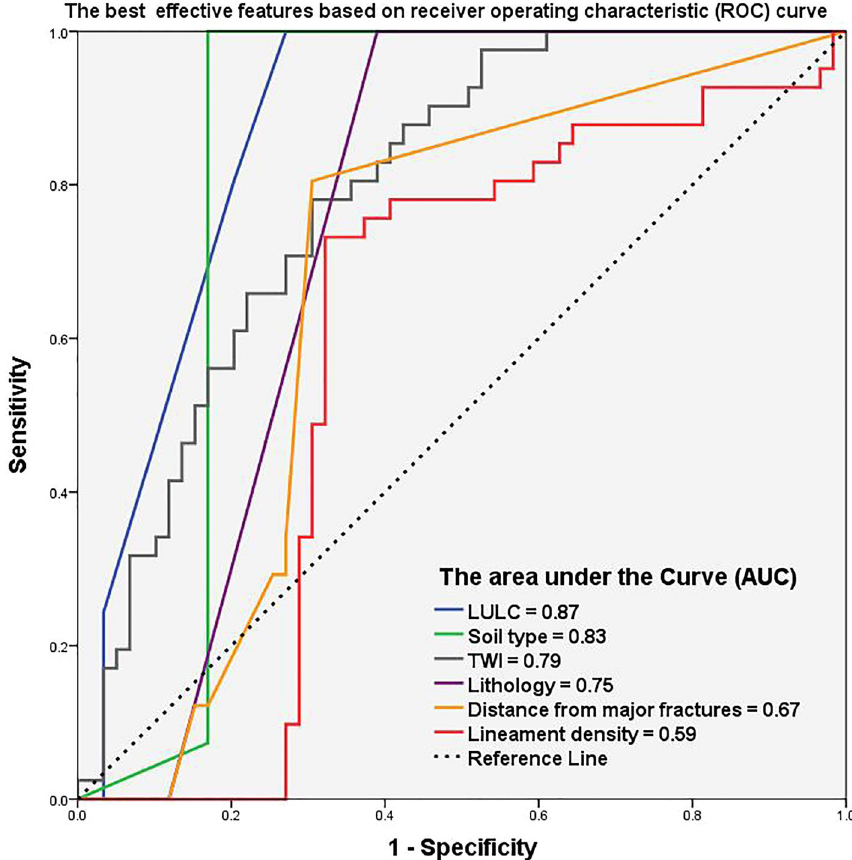
Fig. 11 The most important effective features based on the AUC of ROC